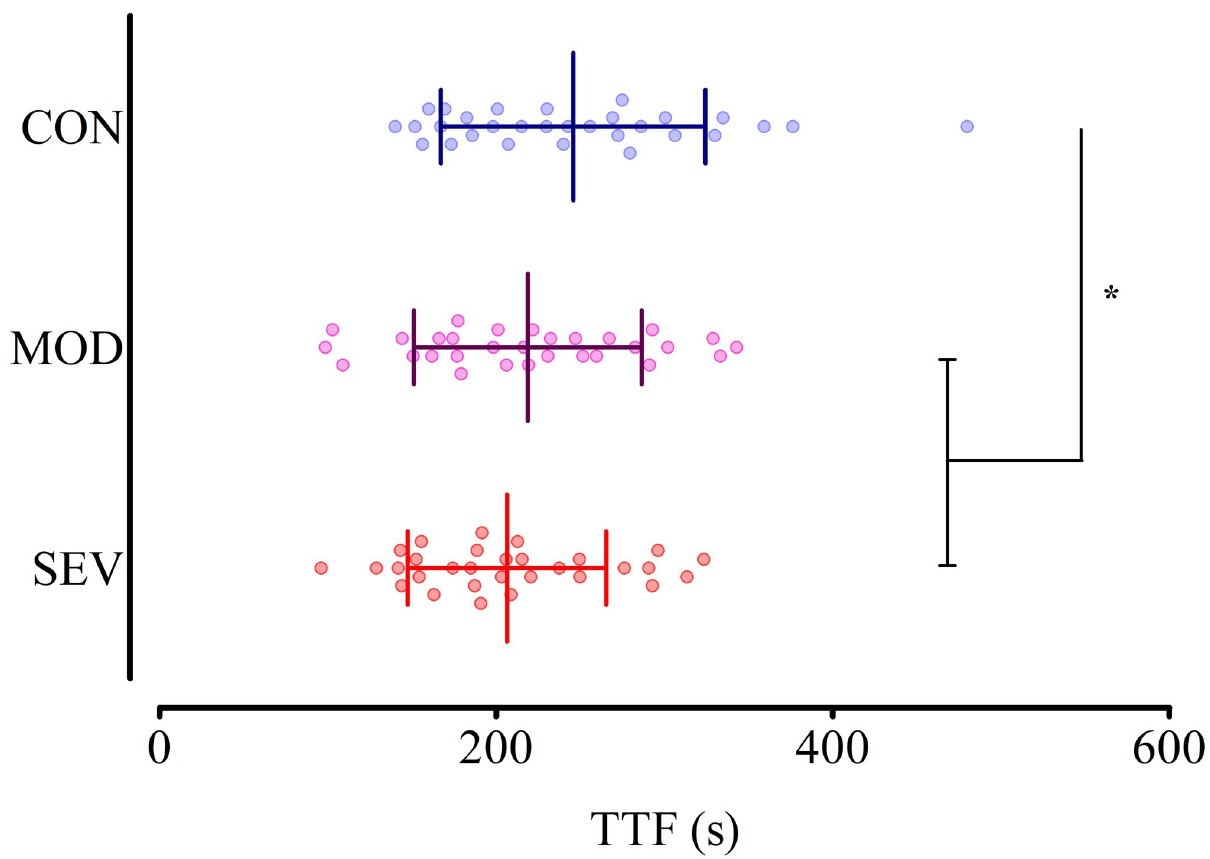
Fig 2. The effect of the subjective intensity of the pre-induced state of fatigue on endurance performance. Knee extensor endurance performance presented for the control (CON; blue), moderate RoF (MOD; purple) and severe RoF conditions (SEV; red). Lines and error bars indicate condition means and standard deviations, respectively. � : Time to task failure (TTF) significantly different in MOD and SEV compared to CON (p <